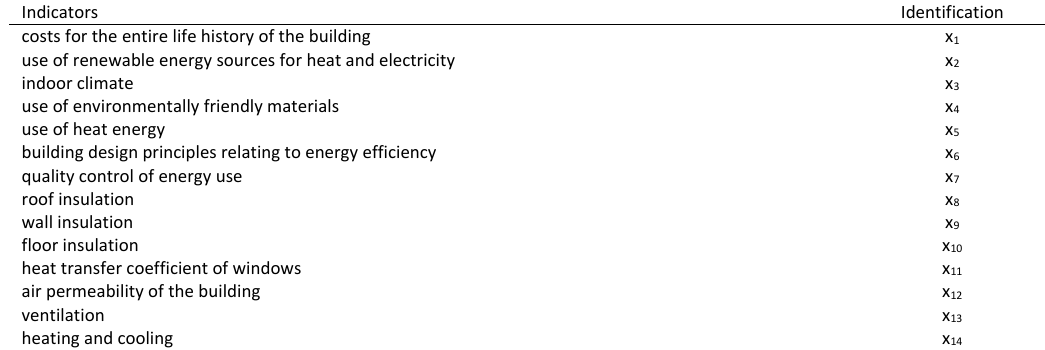
Table 1: System of indicators for conducting energy audits and constructing an energy profile